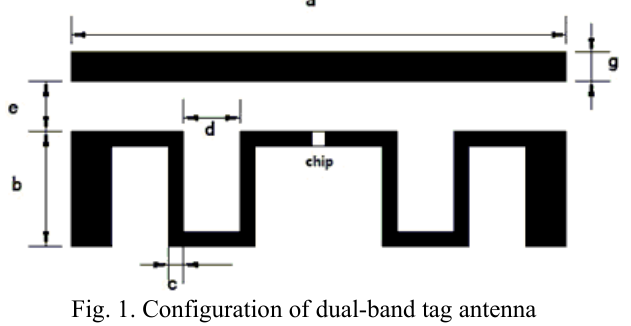
Fig. 1. Configuration of dual-band tag